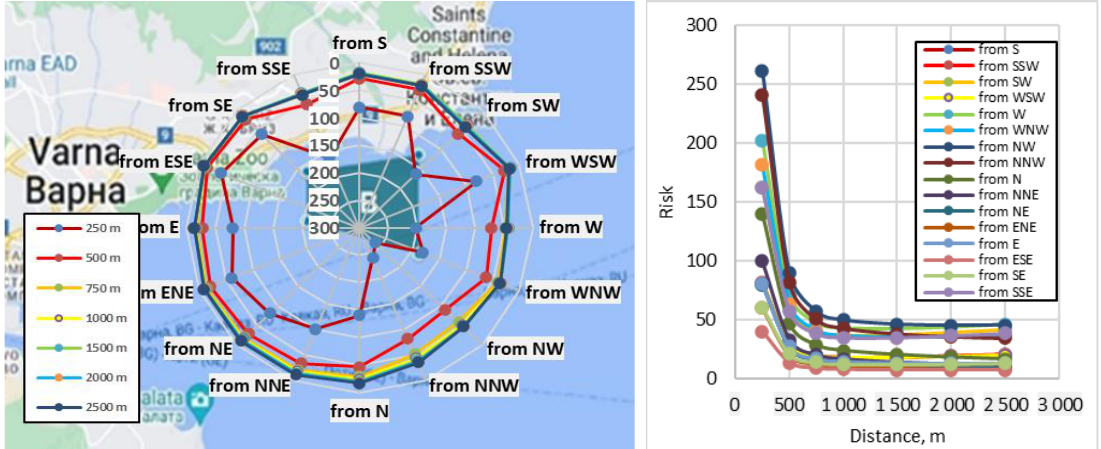
Figure 19. Risk of 𝑁𝑂 x air pollution as a function of wind direction, conditional on distancing, in a one-year return period.